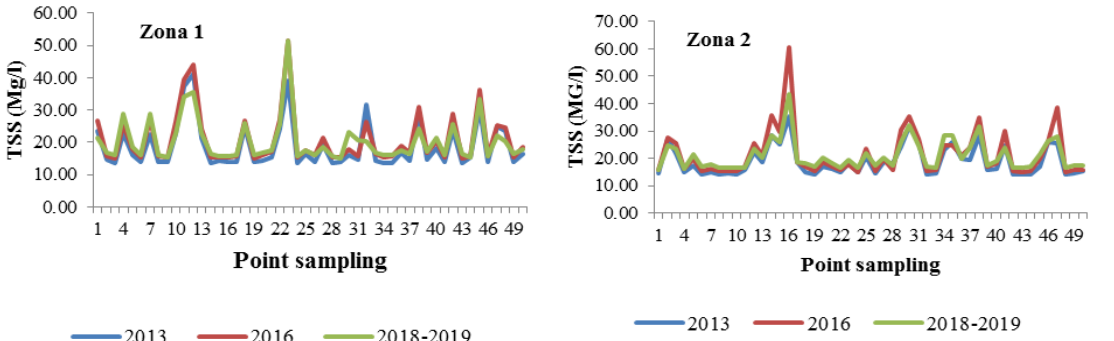
Figure 4. TSS (Mg / l) at each sampling point in Bontosua island as zone 1 and Ballang Caddi island as zone 2 Spermonde waters in the east to west season on September-November 2013, 2016, dan